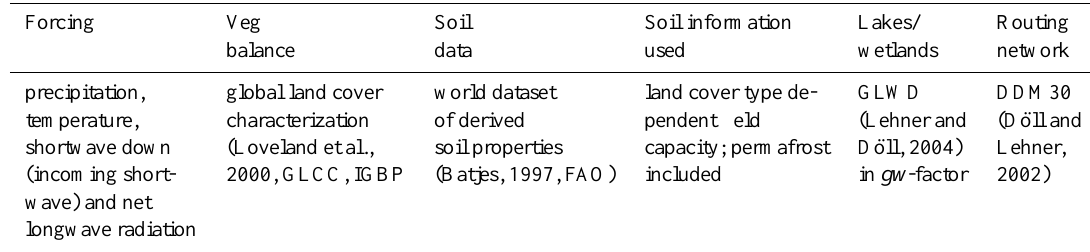
Table 1. WaterGAP model setup